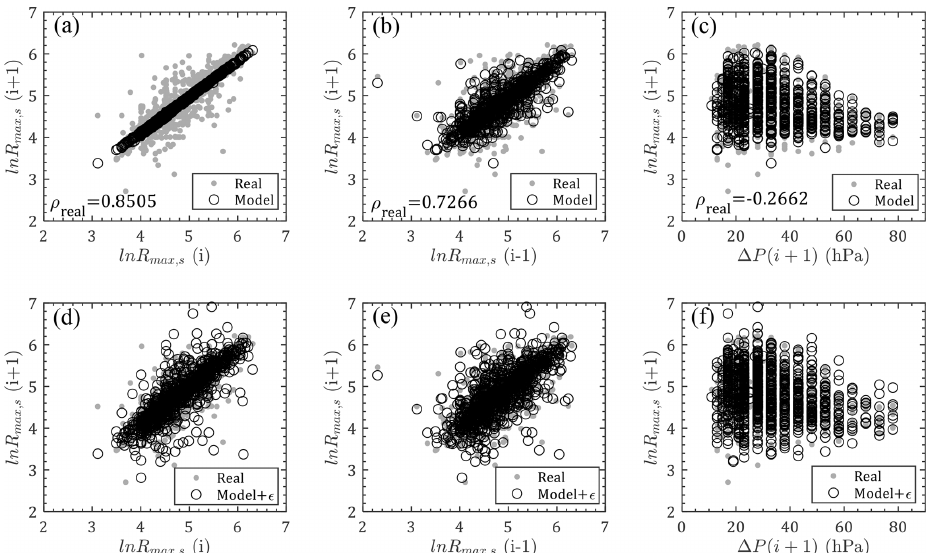
Figure 10. Comparison of ln R max , s between model and real observations: (a–c) relations between ln R max , s (i) , ln R max , s (i − 1 ) , (cid:49)P(i + 1 ) and ln R max , s (i + 1 ) without errors; (d–f) relations between ln R max , s (i) , ln R max , s (i − 1 ) , (cid:49)P(i + 1 ) and ln R max , s (i + 1 ) with errors ( ρ real is the correlation coefficient for real observation